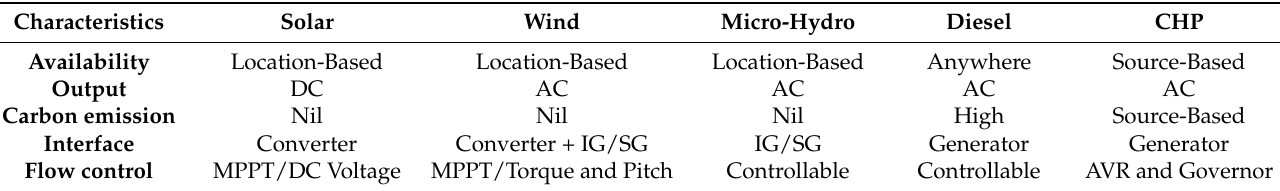
Table 1. Characteristics of distributed generation